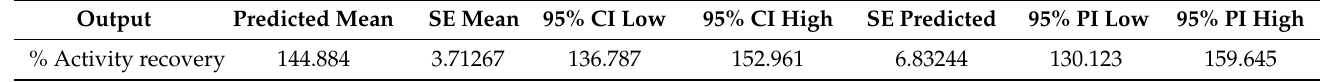
Table 5. Predicted outputs for optimal point. CI—Confidence Interval. Output Predicted